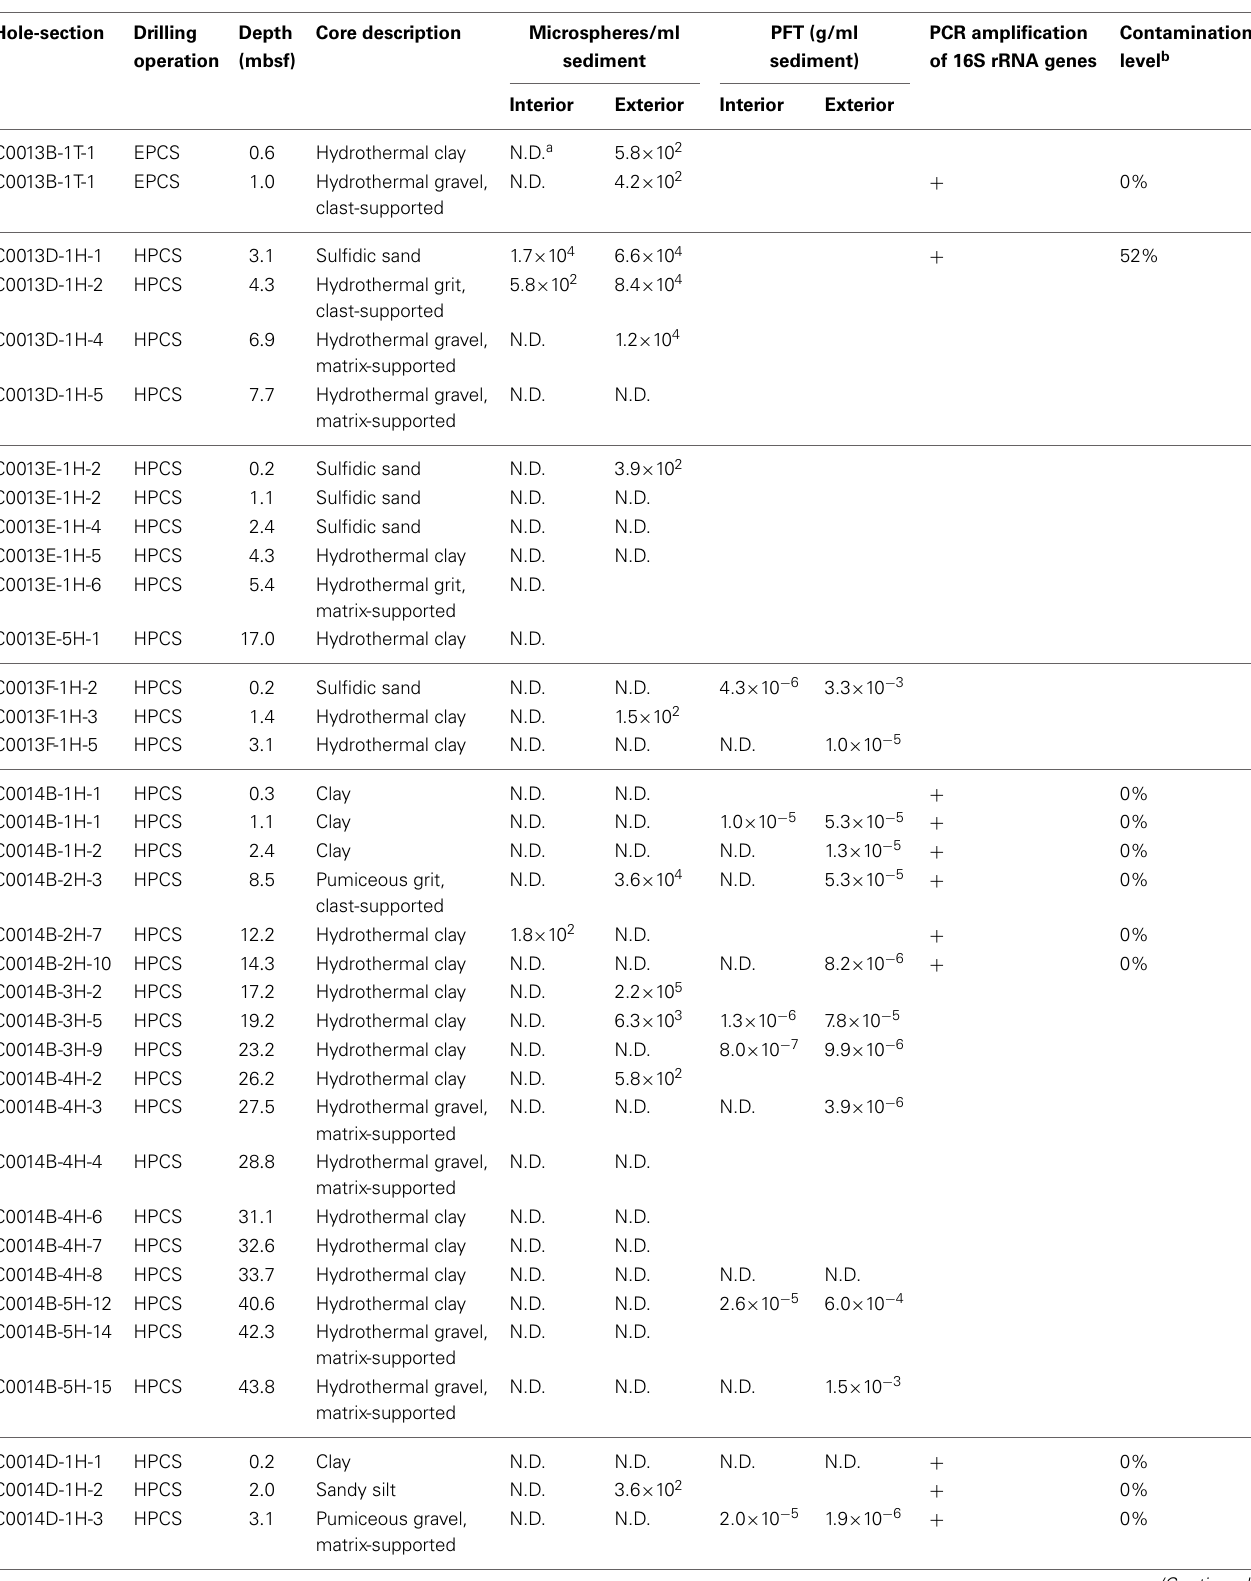
Table 1 | Results of contamination test using PFT, fluorescent microsphere and the 16S rRNA gene amplification.